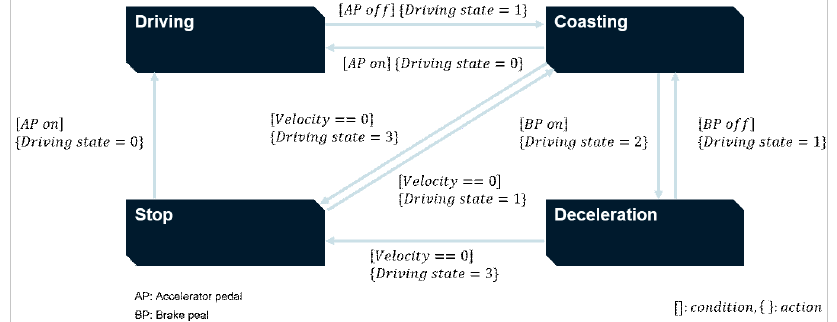
Figure 2. State flow chart of driving state recognition algorithm.